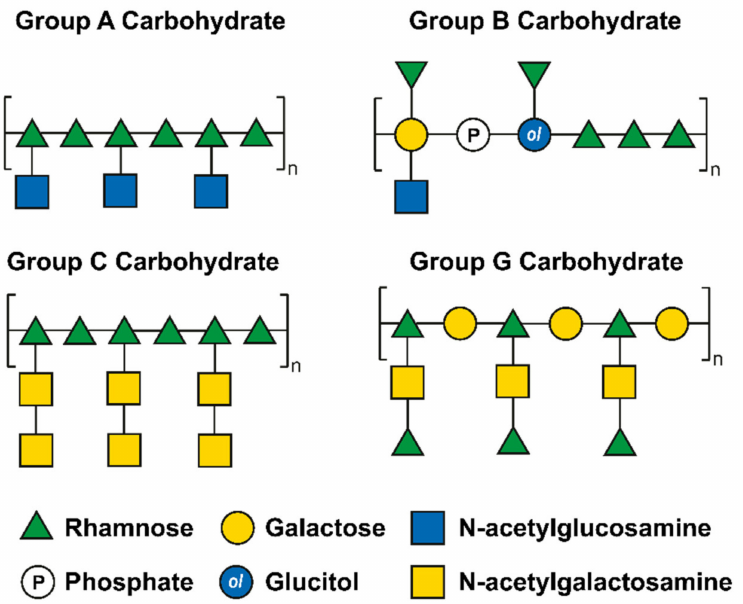
Figure 6. Different types of streptococcal glycan repeating units according to the Lancefield classi- fication. The representation follows the shapes and colors of the SNFG representation for carbohy- drates